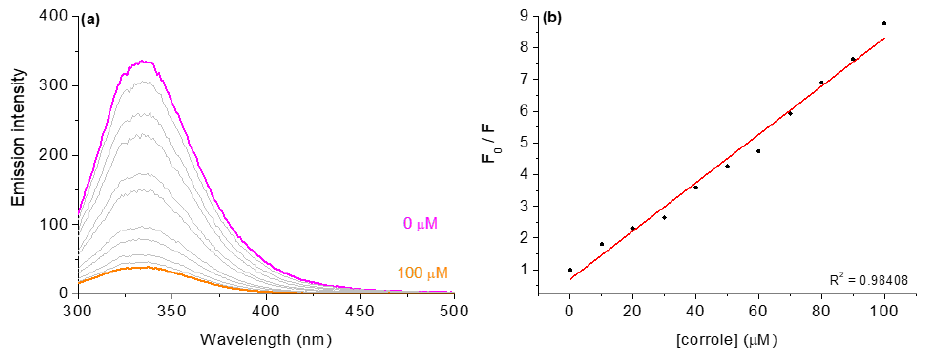
Figure 7. Steady-state fluorescence emission spectra for ( a ) HSA without and in the presence of corrole 3 , in DMSO(5%)/Tris-HCl pH 7.4 mixture buffered solution. Graph ( b ) shows the plot F 0 /F versus [corrole]. [corrole] = 0 –100 μM.